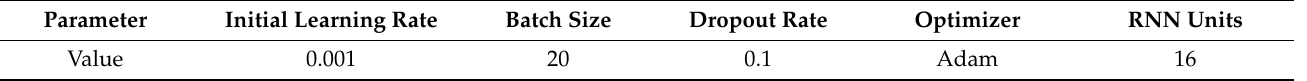
Table 1. Parameters of the GRU model.